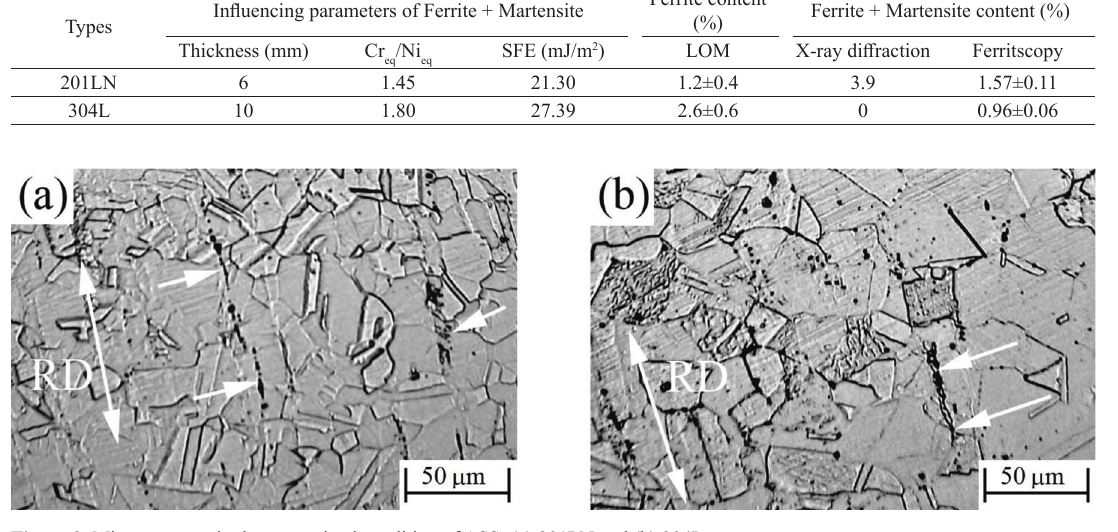
Figure 2. Microstructure in the as-received condition of ASS: (a) 201LN and (b) 304L.